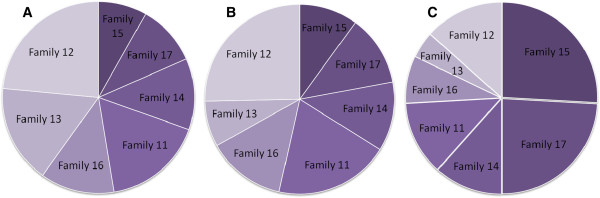
An illustration of experimental selection, as a proportional shift between families during the experiment. The change in relative representation of individuals between the seven families defined as ‘unknown’, at different stages of the trials. A: Initial number of copepodids from each family at the infection. B: Number of lice present at termination of the common-garden trial (34 DPI). C: Final proportions of surviving individuals after the EB trial. Families are ranked by their performance in the EB-trial and plotted in falling order, from the darkest slice at 12 o’clock, representing the family scoring highest, and descending clockwise.